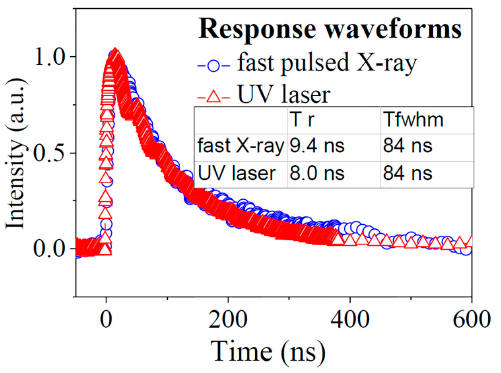
Figure 7. Response waveforms of a 4H-SiC detector with a dimension of 20 mm × 20 mm × 20 μ m at a reverse bias of 400 V: response waveform to fast pulsed X-ray (blue open circle) and to ultra UV-light (red open triangle).